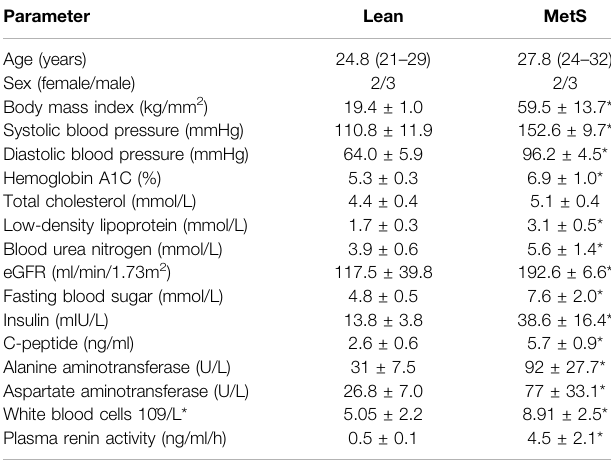
TABLE 1 | Clinical, laboratory, and demographic data of Lean and MetS patients ( n (cid:1) 5 each). Parameter